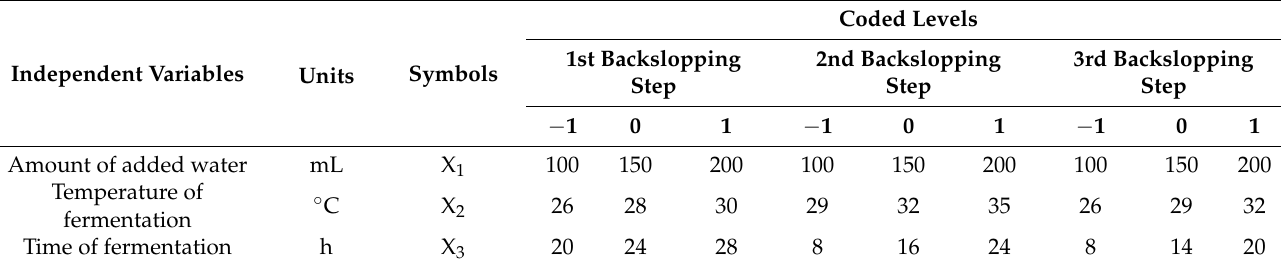
Table 1. The three independent variables/parameters and